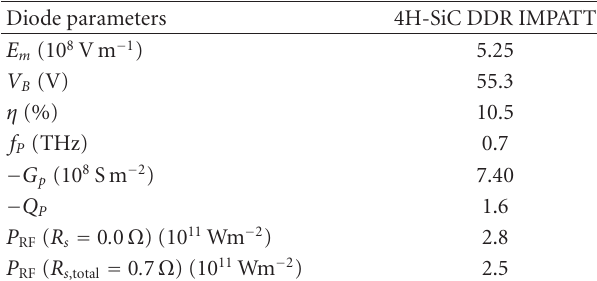
Table 2: Dc and small-signal properties of 4H-SiC IMPATT diode. Diode